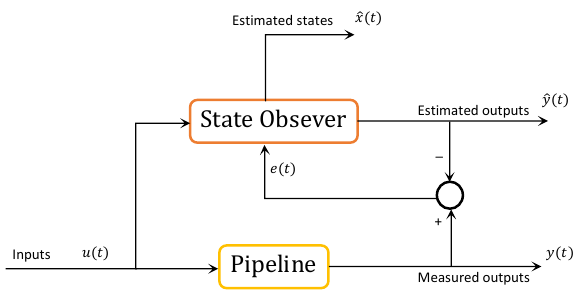
Figure 2. State estimation process for the pipeline.